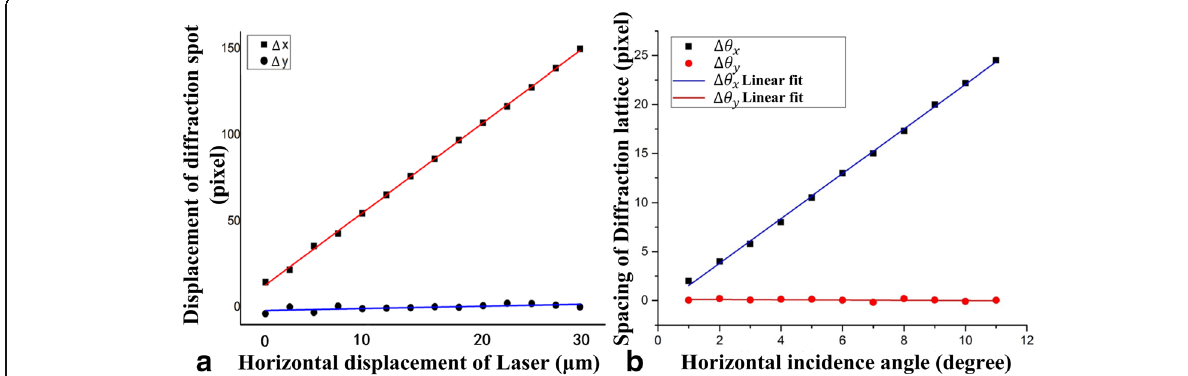
Fig. 4 Characterization of four degrees of freedom. a Displacement of laser source depends on the displacement of the diffraction spots. b Incident angle of laser source depends on the gap between of diffraction